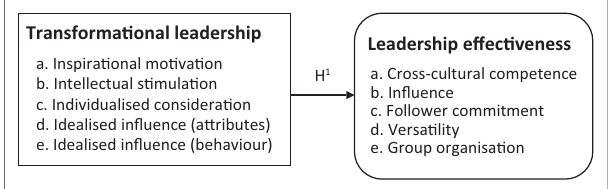
FIGURE 1: Proposed hypothesised framework of the relationship between transformational leadership and leadership